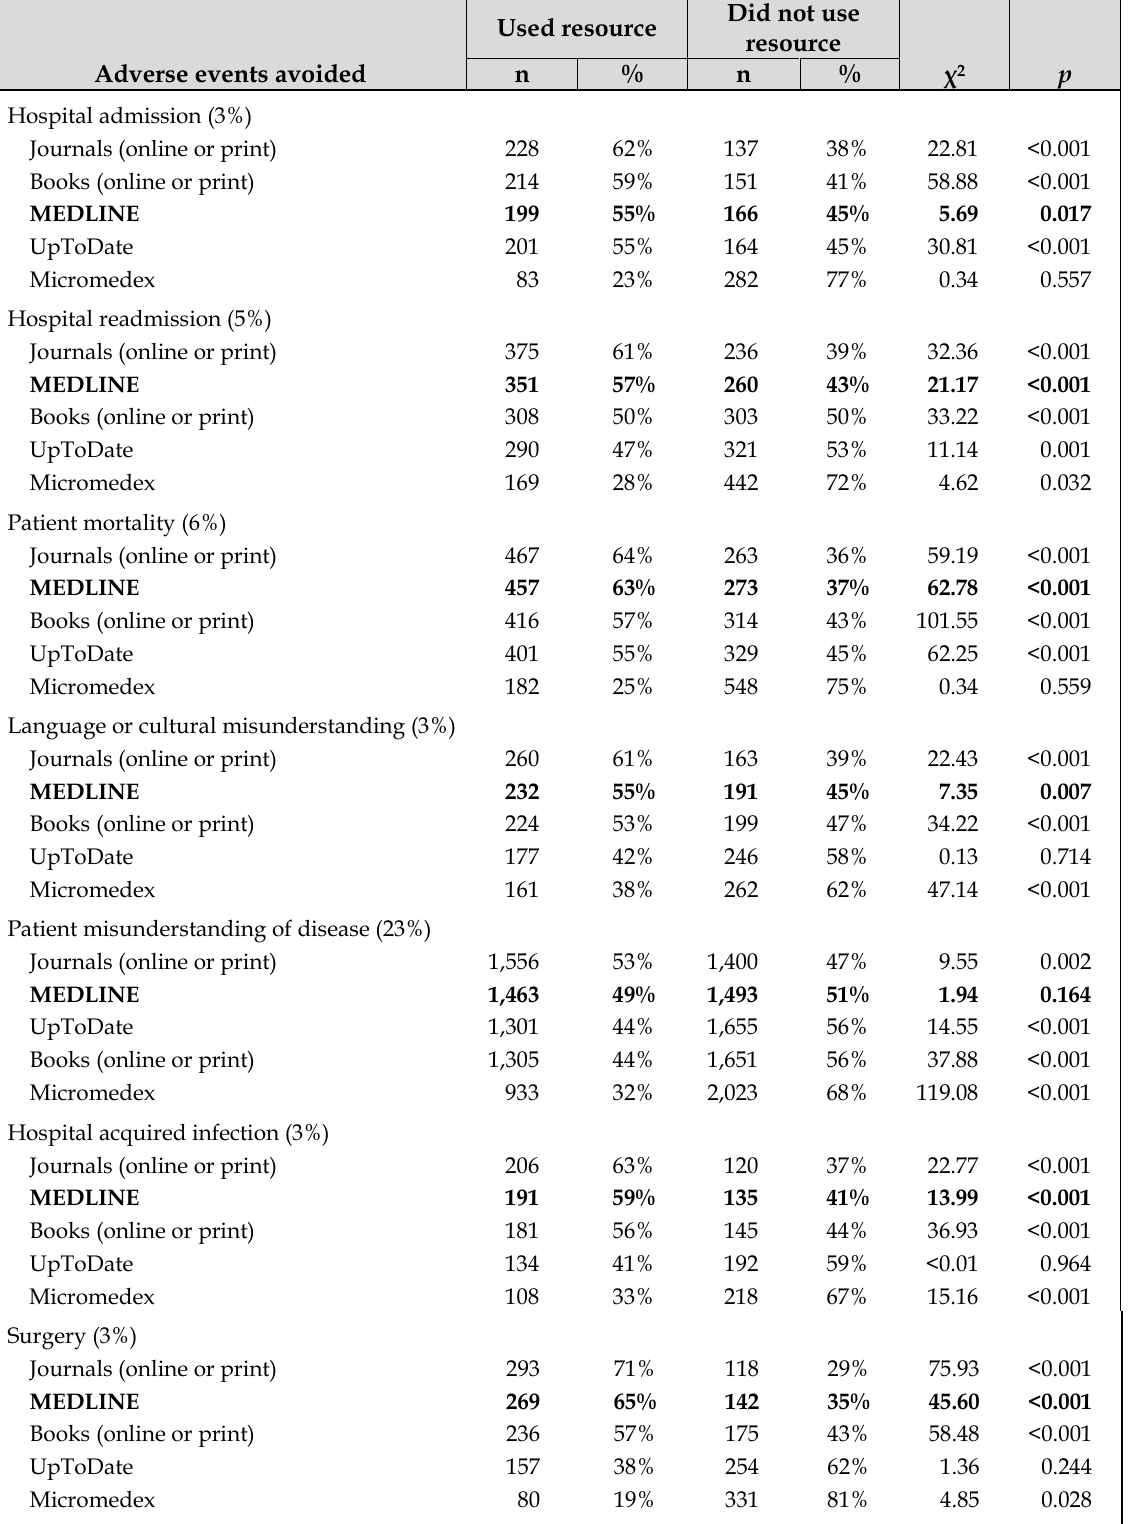
Table 3 Percent of respondents who used each information resource among those who avoided adverse events as a result of the information obtained in their searches Used Adverse events avoided